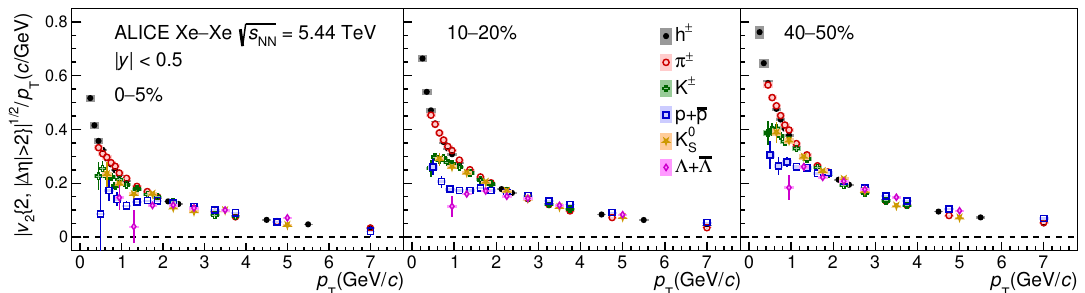
Figure 10. | v 2 | 1 / 2 /p T of inclusive charged hadrons (h ± ) [22], π ± , K ± , p+ p , K 0 as function of p T for various centrality intervals. Bars (boxes) denote statistical (systematic)